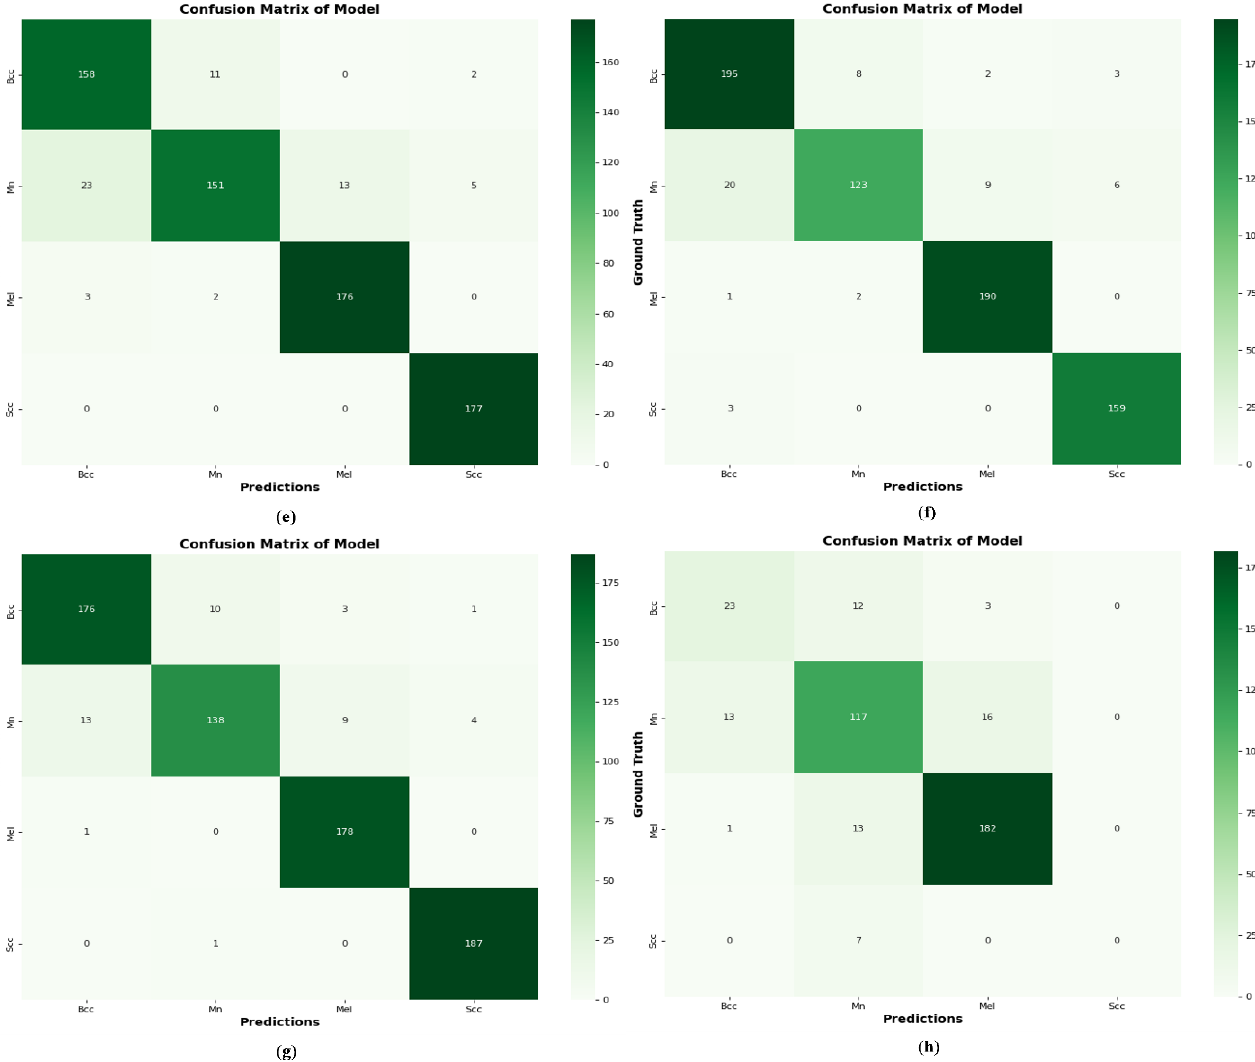
Figure 14. Using a confusion matrix to compare the proposed DSCC_Net with other deep networks; ( a ) Vgg-16, ( b ) Vgg-19, ( c ) EfficientNet-B0, ( d ) ResNet-152, ( e ) Inception-V3, ( f ) MobileNet, ( g ) Proposed Model with SMOTE Tomek, and ( h ) Proposed Model without SMOTE Tomek.